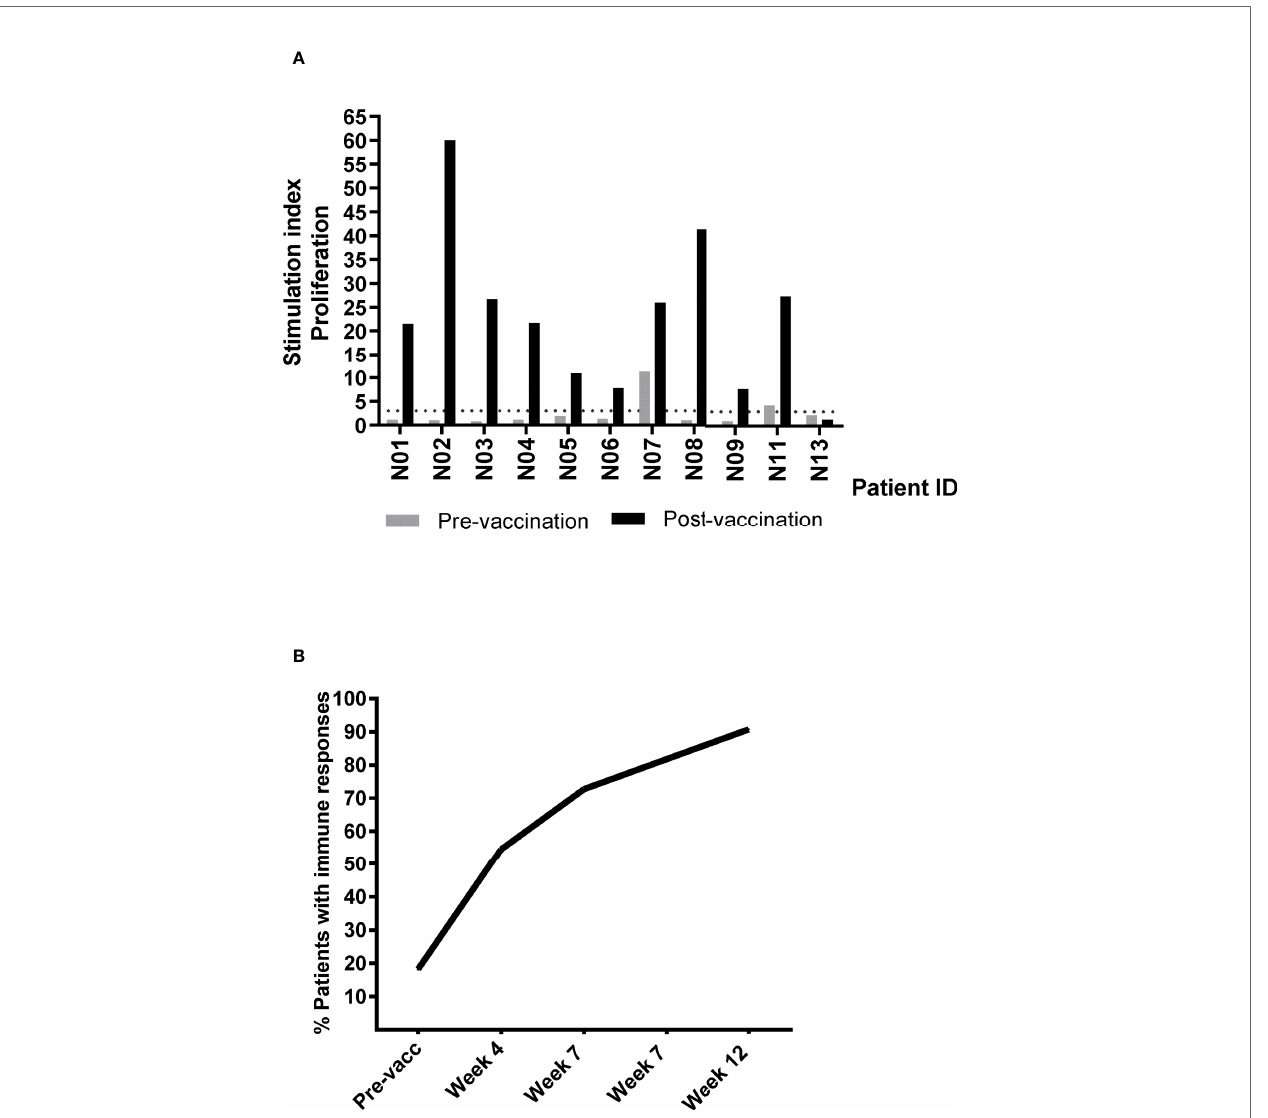
FIGURE 3 | Summary of detected pre- and post-vaccination T cell responses against UV1 peptides. (A) T cell proliferation against UV1 peptides in pre- and post- vaccination blood samples from patients evaluable for immune response, depicting the strongest post-vaccination T cell response detected against the hTERT peptide mix for each patient. ( N =11). Proliferation was measured in response to peptide-loaded PBMC by 3 H-thymidine incorporation. A stimulation index (SI) of >3 was considered as an immune response. The dotted line indicates SI=3. (B) Cumulative percentage of evaluable patients exhibiting immune responses to UV1 peptides. Immune responses at baseline were detected in two